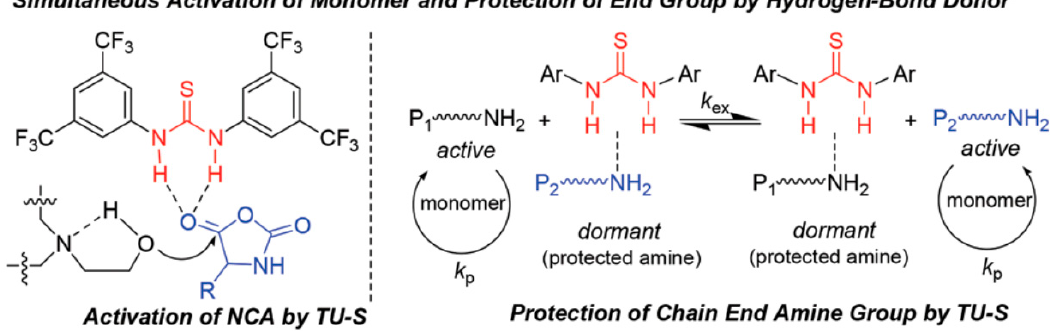
Figure 14. Hexamethyldisilazane (HMDS)-mediated NCA polymerization through trimethylsilyl (TMS) carbamate group. Reproduced with permission from reference [72,73].